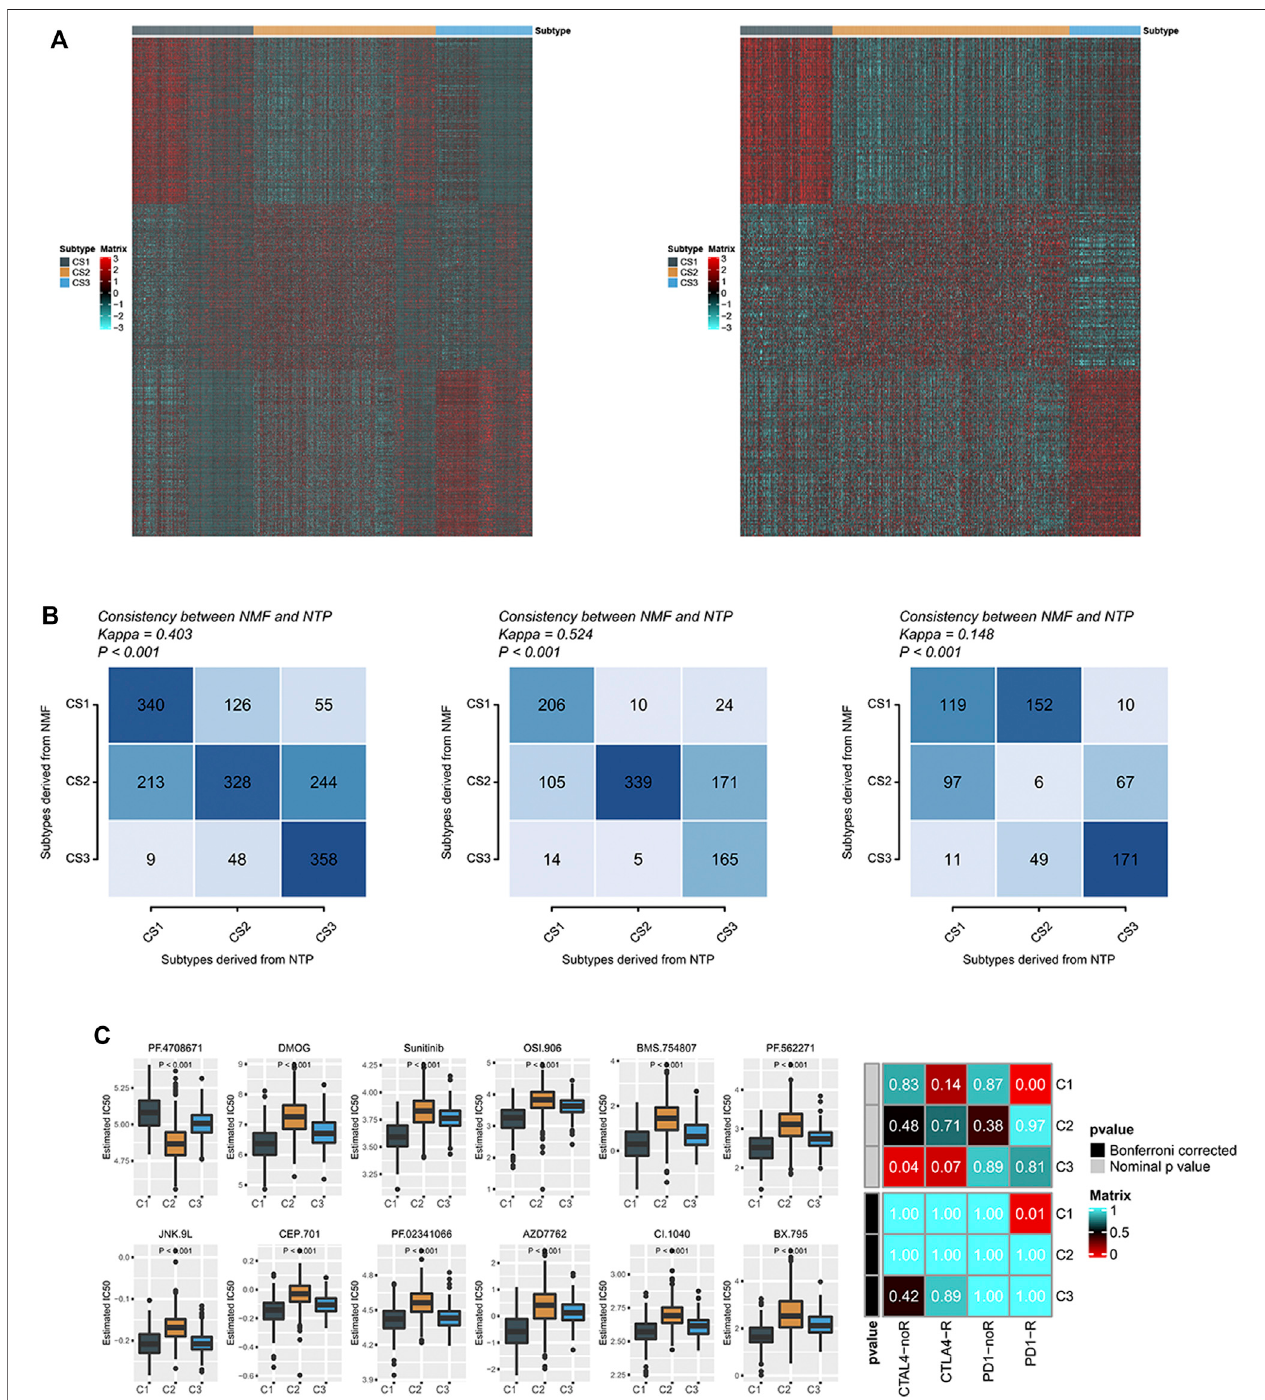
FIGURE 5 | (A) Heatmaps of the expression levels of 90 gene classi fi ers; (B) The consistency between the prediction of molecular subclasses of breast cancer by 90 gene classi fi ers and the original prediction based on NMF; (C) There were signi fi cantdifferencesin sensitivityanalysisof 12drugs among different subtypes ofbreast cancer. Sensitivity of different subclasses of CTLA-4 inhibitors and PD-1 inhibitors in breast cancer.